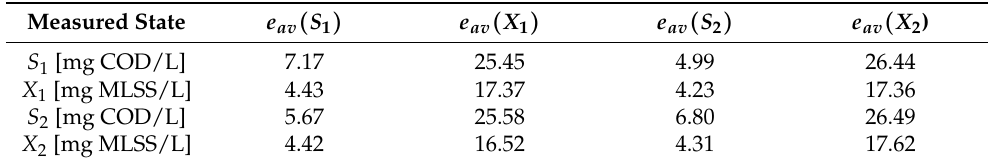
Table 3. Error of the estimated states ( e av ) at different sensor locations. The error values were calculated as an average of N r = 10 simulations over the first 40 days (with a sampling time of dt = 0.01 days corresponding to T = 4000 time steps). N S =